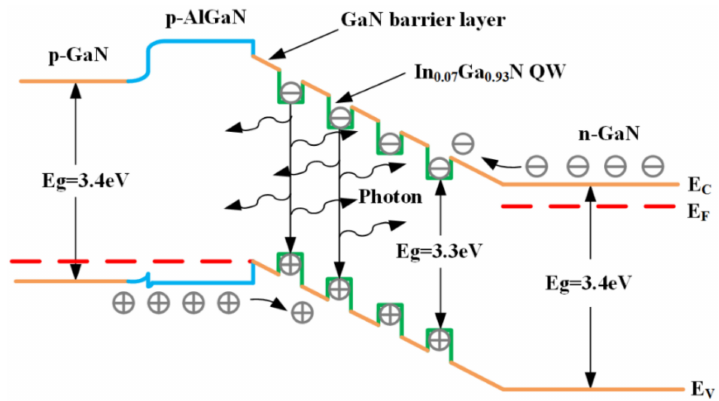
Figure 3. Energy band diagram of the UV LED at forward bias.